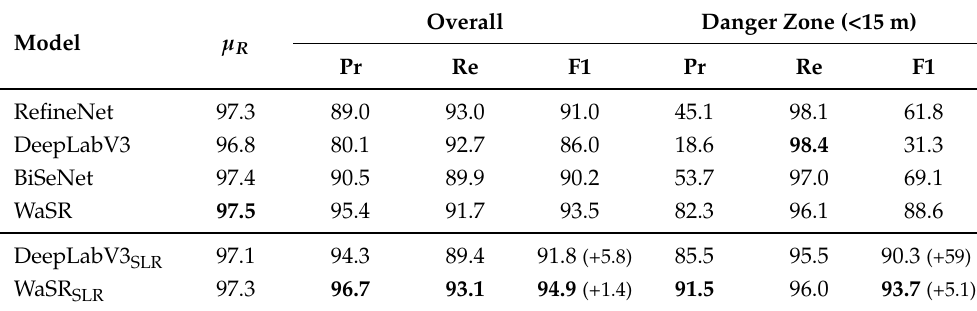
Table 1. Comparison of methods trained with weak annotations using the proposed SLR training (denoted by ( · ) SLR ) and state-of-the-art methods trained classically with dense ground truth labels on the MODS benchmark [1]. Performance is reported in terms of F1 score, precision (Pr), and recall (Re) for dynamic obstacle detection and water–edge detection robustness ( µ R ). Best results for each metric are denoted in bold.